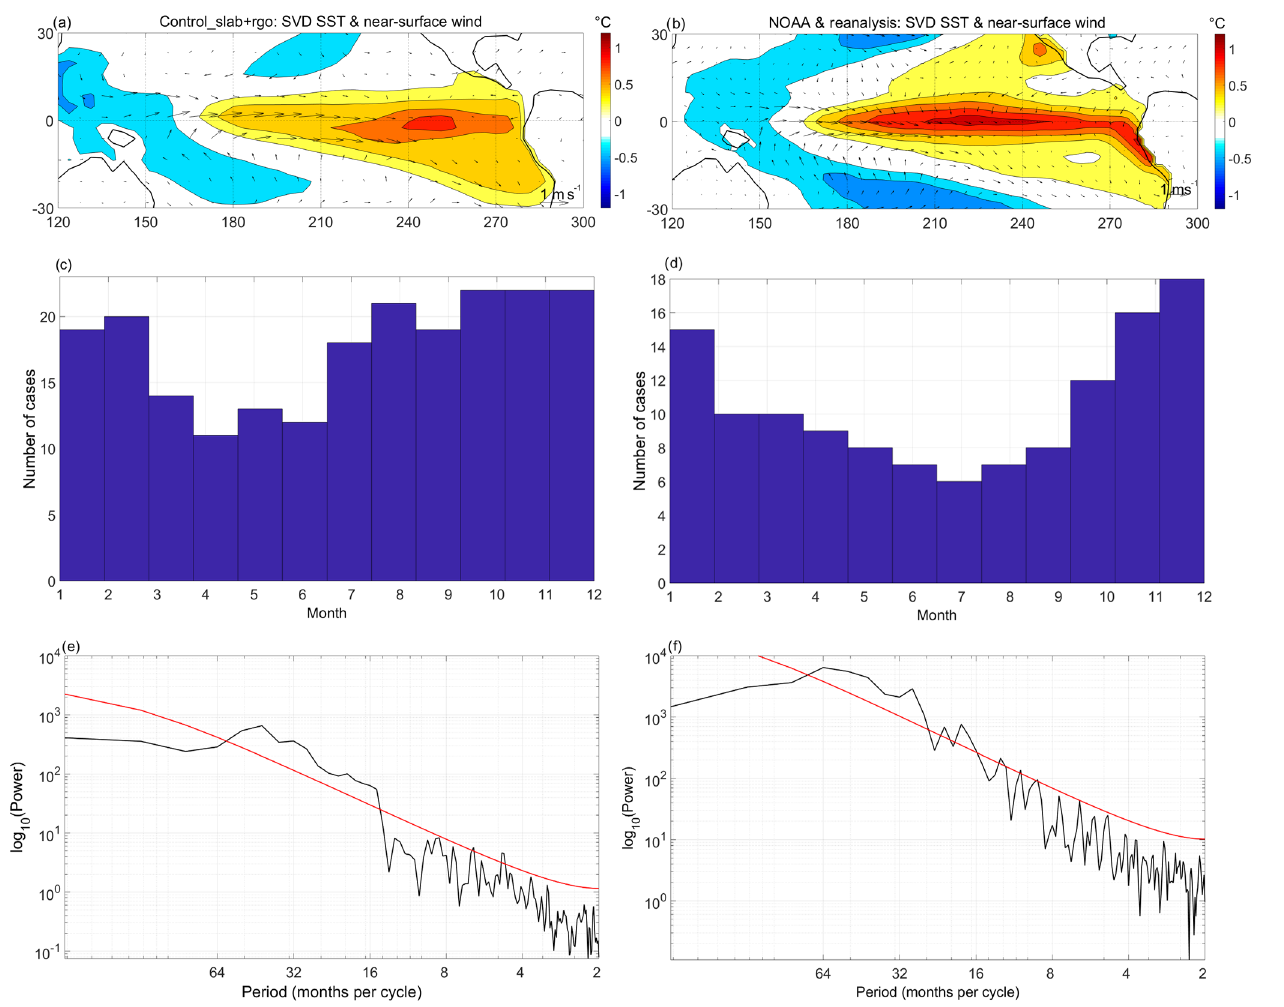
Figure 2. First SVD pattern of SST and near-surface winds in the tropical Pacific Ocean (30 ◦ S–30 ◦ N, 120–300 ◦ E) for the Con- trol_slab + rgo experiment (a, c, e) and NOAA SST and reanalysis data ( b , d , g ; Smith et al., 2008; Kalnay et al., 2006). (a, b) Spatial pattern; contour interval 0.2 ◦ C. (c, d) Histogram showing phase-locking to the seasonal cycle. (e, f) Spectral analysis; the red line indicates the red-noise spectrum.